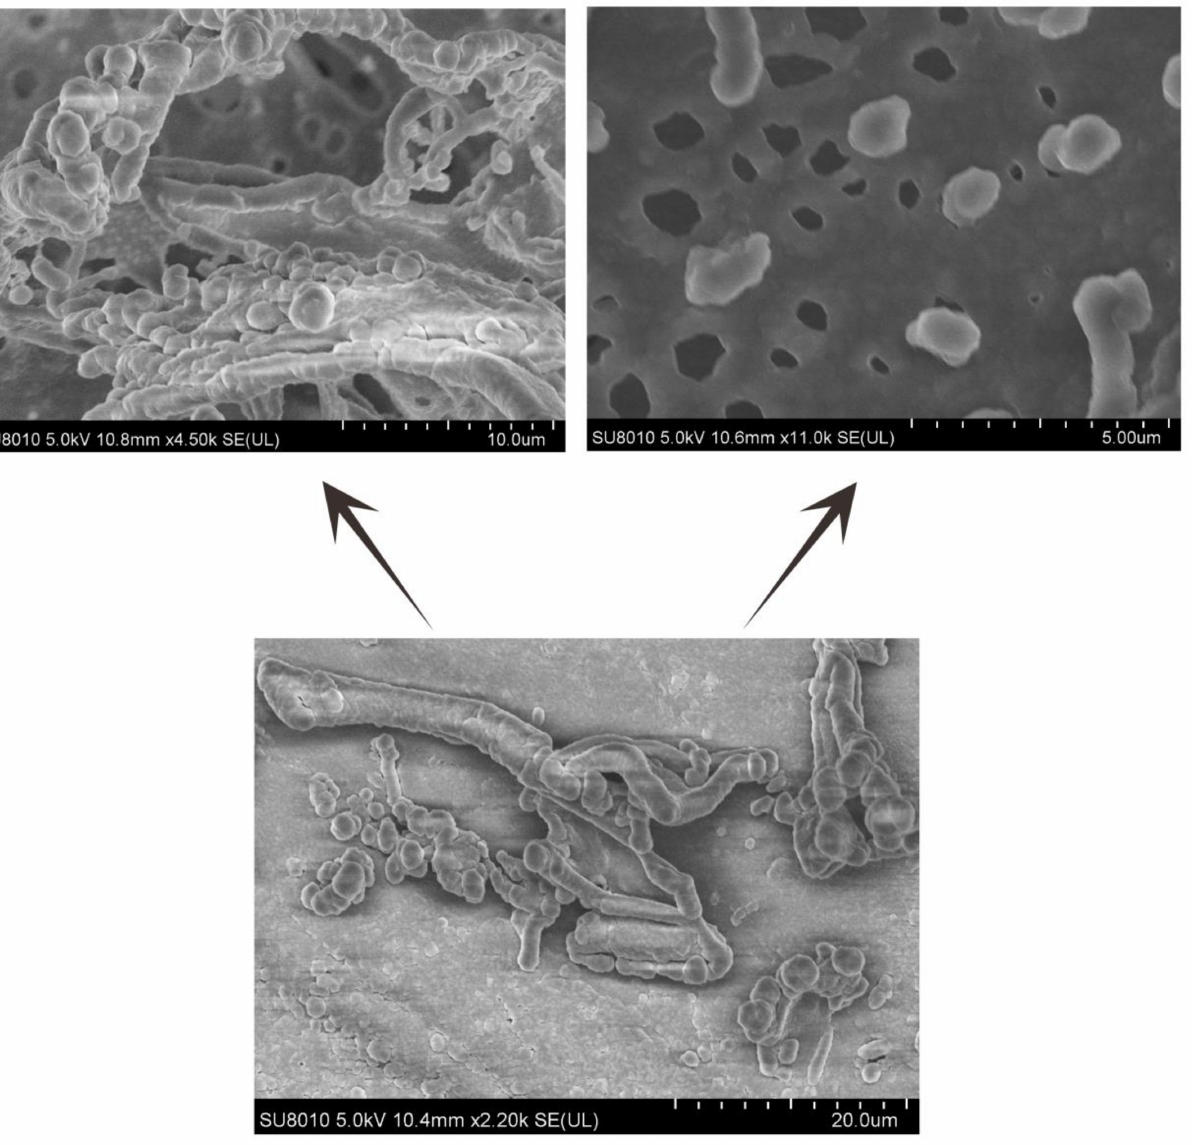
Figure 5. Cryogenic scanning electron microscopy (Cryo-SEM) analysis of